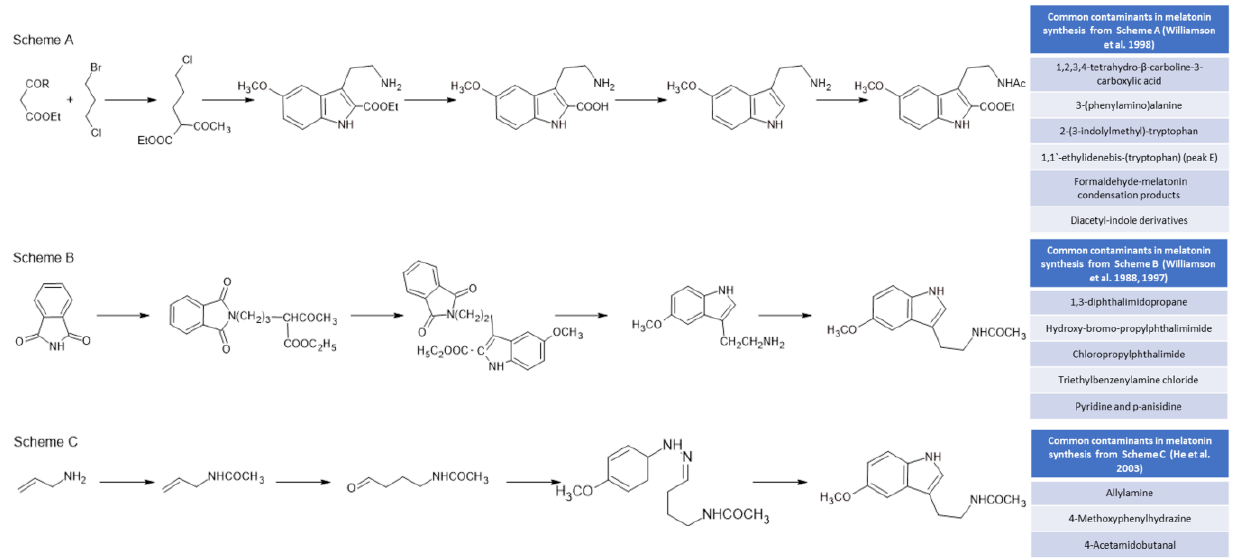
Figure 3. Some chemical melatonin synthesis pathways and their by-products present in synthetic melatonin preparations [101 – 105].